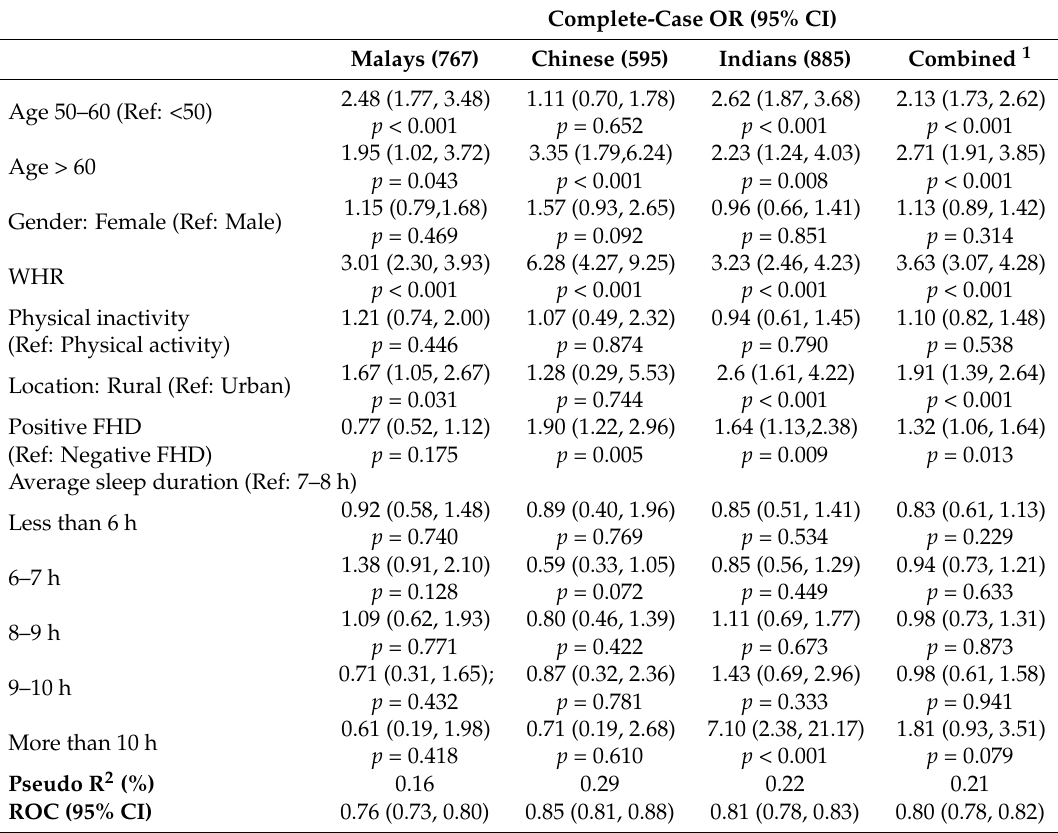
Table 2. Odds ratios, 95% confidence intervals and p -values from complete case analysis (n = 2247). Complete-Case OR (95% CI) Malays (767) Chinese (595) Indians (885) Combined